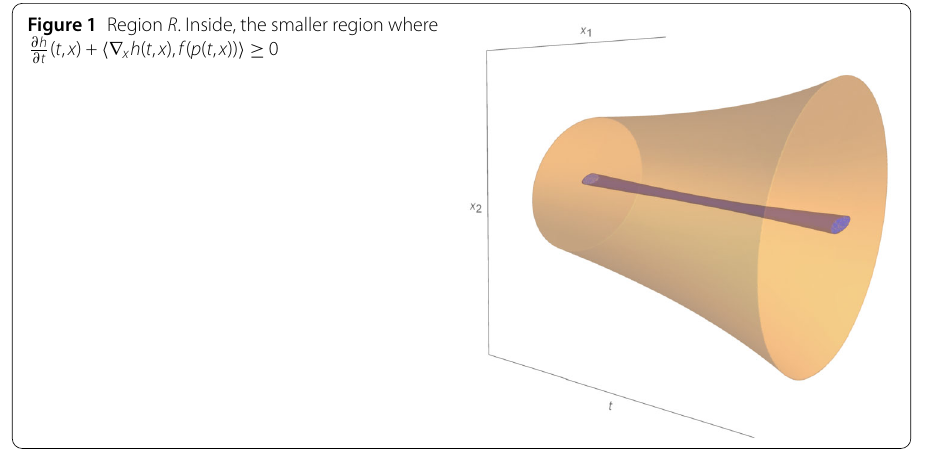
Figure 1 Region R . Inside, the smaller region where ∂